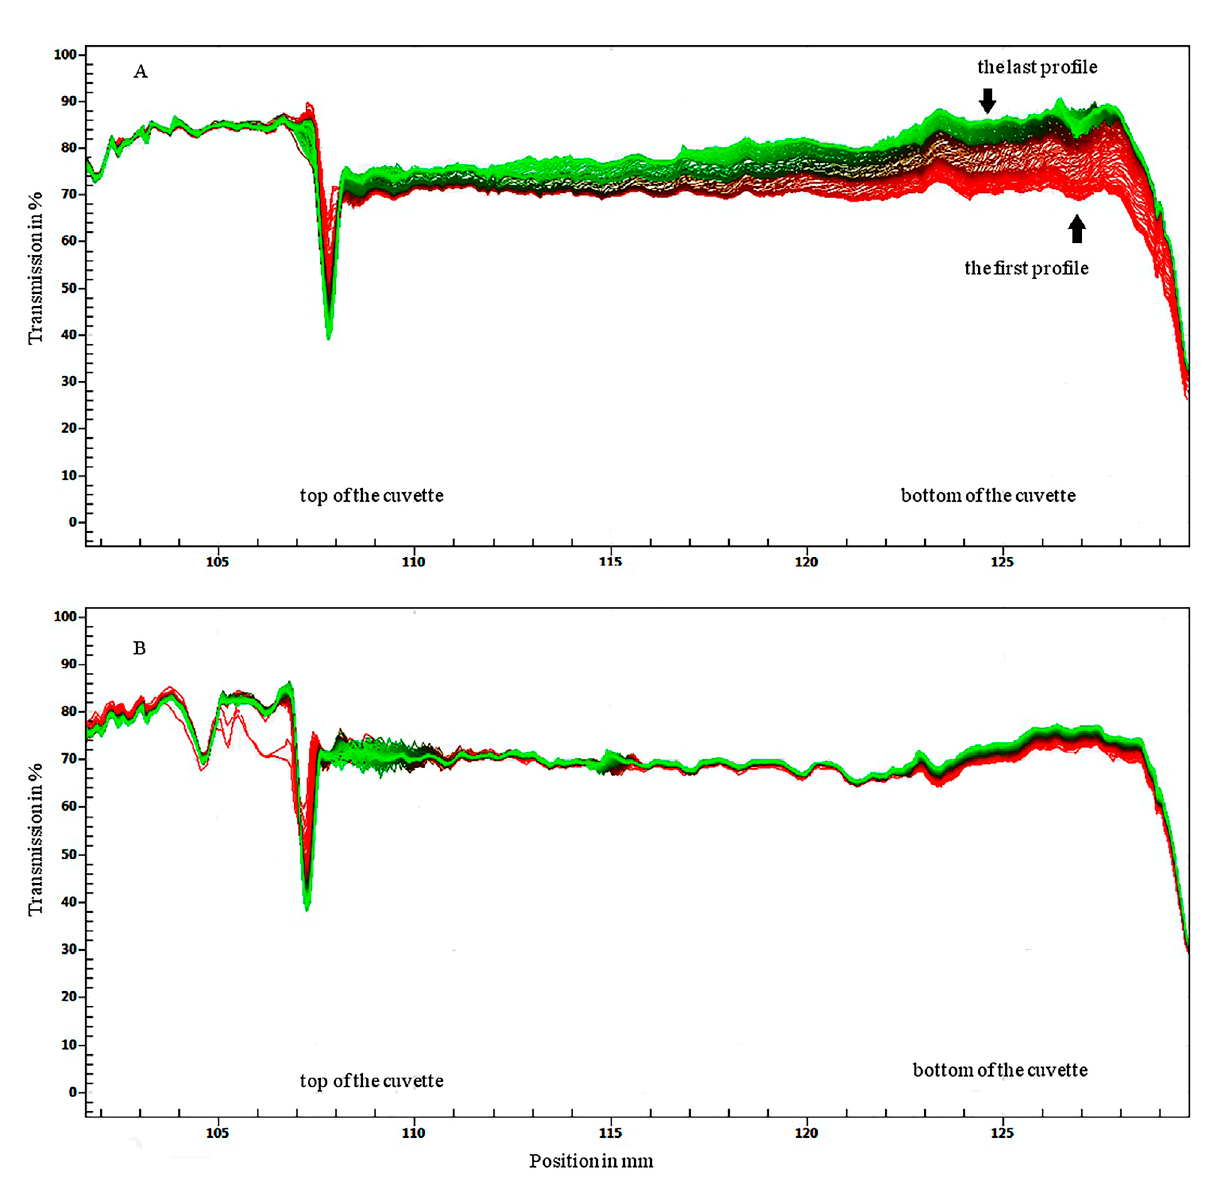
FIGURE 2 - Light transmission profiles through the cell of samples, stored at 4 °C, subjected to centrifugation at 4,000 rpm. (A) LNC and (B) LNC blank Ji